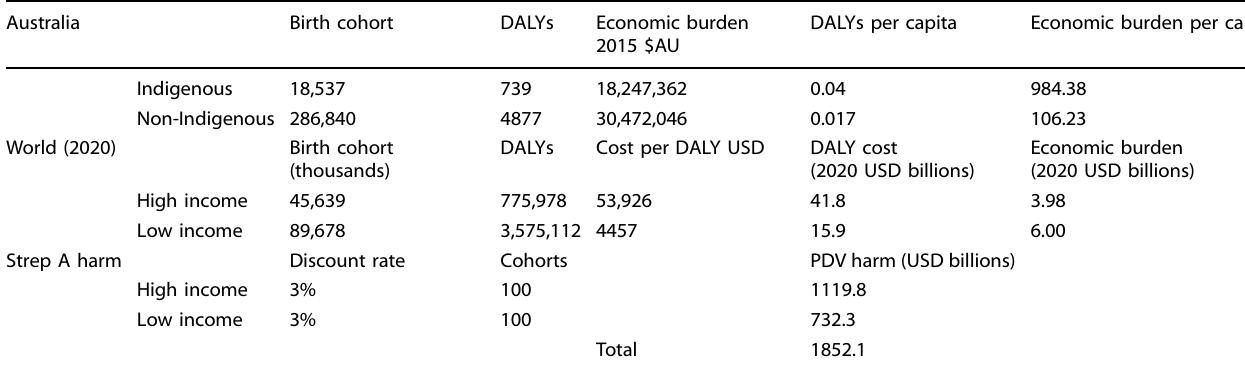
Table 3. Global Strep A harm